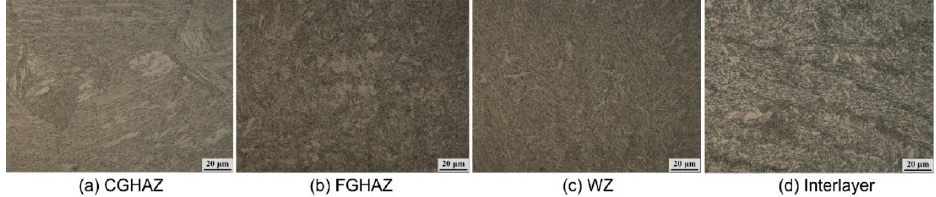
Figure 6. Microstructure of the welded joint with the welding speed of 250 mm/min. ( a ) coarse-grain heat-affected zone; ( b ) fine-grain heat-affected zone; ( c ) weld zone; ( d ) interlayer zone.